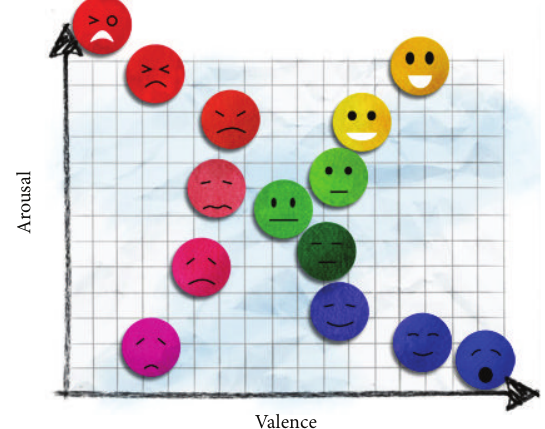
Figure 3: Dimensional model of emotion